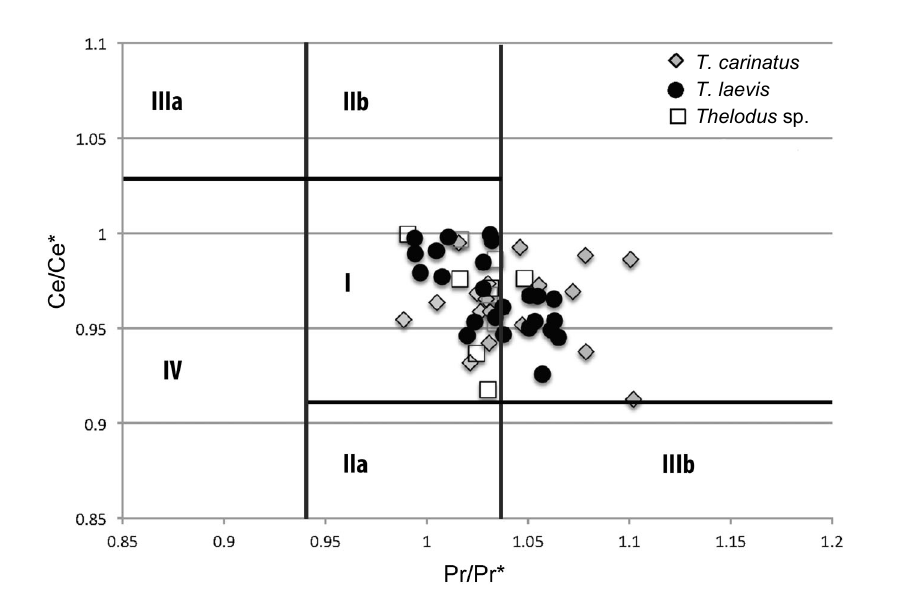
Fig. 3. Ce/Ce* vs Pr/Pr* diagram, where Ce/Ce* = 2Ce SN /(La SN + Nd SN ) and Pr/Pr* = 2Pr SN /(Ce SN + Sm SN ); Field I: no anomaly; IIa: positive La-anomaly causes apparent negative Ce-anomaly; IIb: negative La-anomaly causes apparent positive Ce anomaly; IIIa: real positive Ce anomaly; IIIb: real negative Ce anomaly; IV: positive La-anomaly disguises positive Ce anomaly. After Bau & Dulski